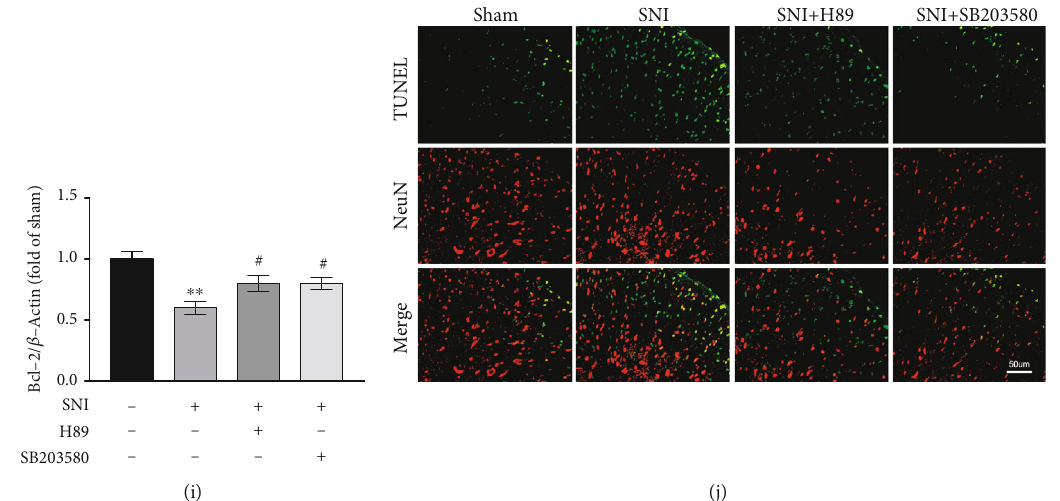
Figure 8: PKA and p38MAPK inhibitors reduce in fl ammation and apoptosis. (a – c) Western blots and quanti fi cation of TNF- α and IL-1 β expression in the spinal cord ( n = 3 ). ∗ P < 0 : 05 versus Sham group, # P < 0 : 05 , ## P < 0 : 01 versus SNI group. (d, e) TNF- α (d) and IL-1 β € levels in the spinal cord as measured by ELISA ( n = 3 ). ∗∗∗ P < 0 : 001 versus Sham group, ### P < 0 : 001 versus SNI group. (f – i) Western blots and quanti fi cation of bax, bcl-2, caspase3, and caspase9 expression in the spinal cord ( n = 3 ). ∗ P < 0 : 05 , ∗ P < 0 : 01 versus Sham group, # P < : 05 , ## P < 0 : 01 versus SNI group. (j) TUNEL and NeuN double labeling. TUNEL-positive cells are green; NeuN is red.